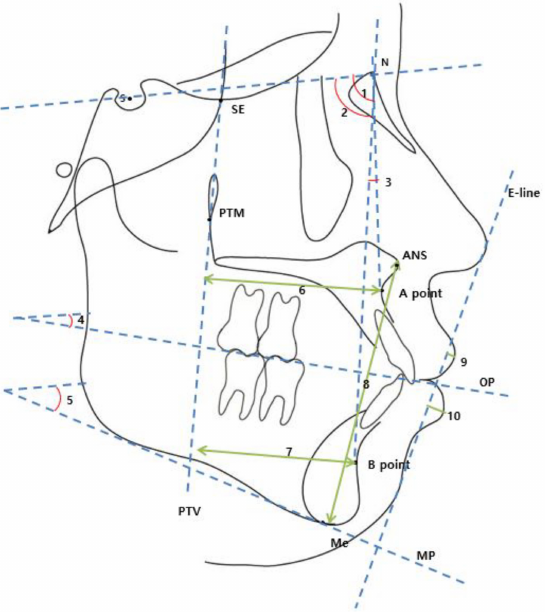
Figure 2. Cephalometric skeletal and soft tissue measurements. 1, SNA; 2, SNB; 3, ANB; 4, SN-OP (occlusal plane angle); 5, SN-MP (mandibular plane angle); 6, PTV to A point; 7, PTV to B point; 8, ANS-Me (lower anterior facial height); 9, upper lip to E-line; 10, lower lip to